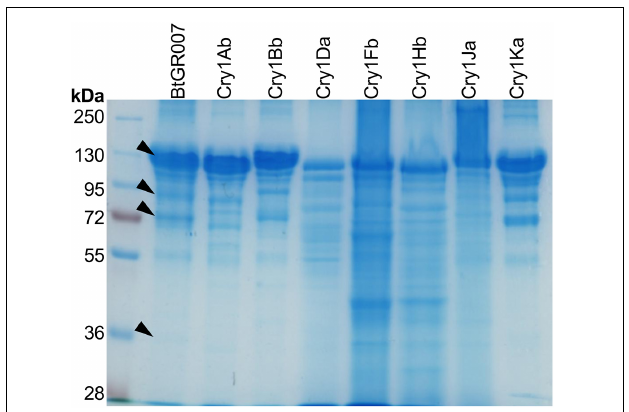
FIGURE 3 | SDS-PAGE of parasporal crystal proteins. Proteins of Bt GR007 analyzed by LC-MS are labeled with black arrows. The cry genes codifying for Cry1Ab, Cry1Bb, Cry1Da, Cry1Fb, Cry1Hb, Cry1Ja, and Cry1Ka proteins were cloned in pHT315 shutter vector and electrotransformed into acrystalliferous Bt 407 strain. All transformant Bt strains were grown until sporulation and the spore/crystal mixture of these strains were analyzed by SDS-PAGE. Cry1Ab, Cry1Bb, Cry1Da, Cry1Fb, Cry1Hb, Cry1Ja, and Cry1Ka correspond to the protein profiles observed in each one of these Bt transformant strains.